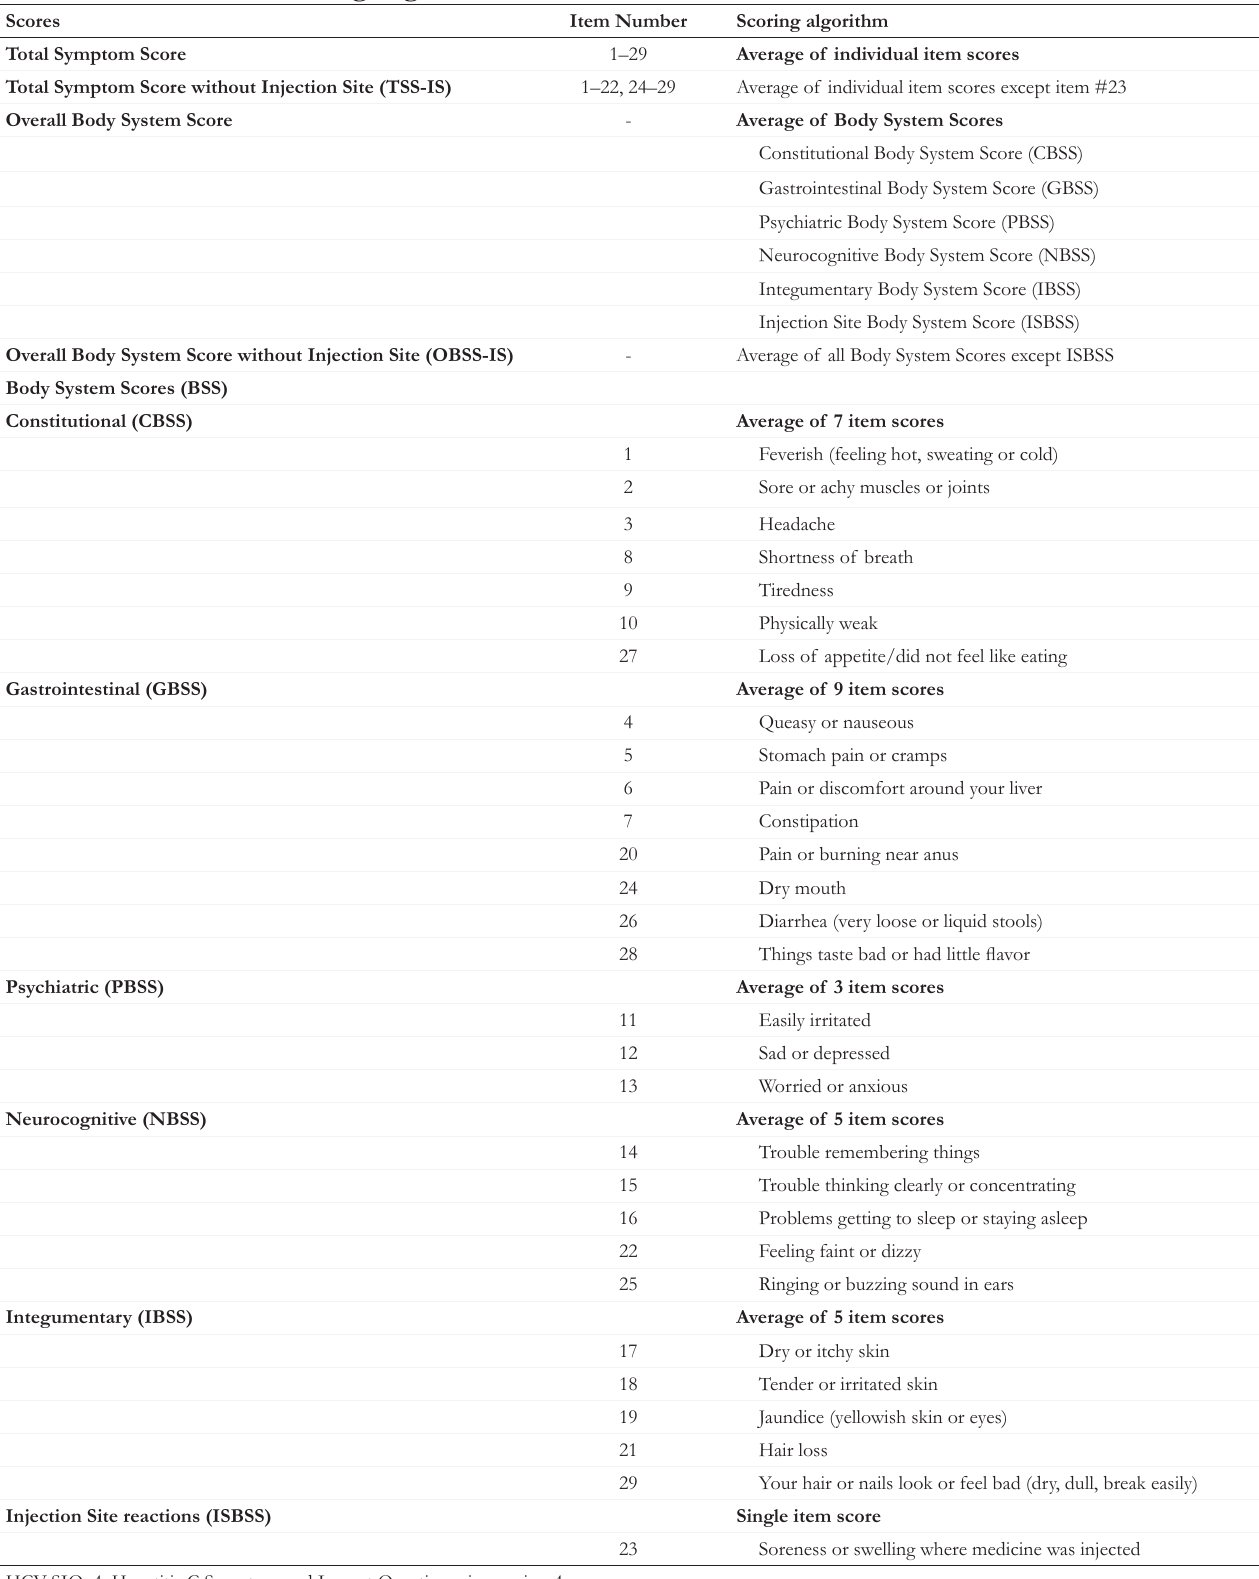
Table 1. HCV-SIQv4 Scoring Algorithms Scores Item